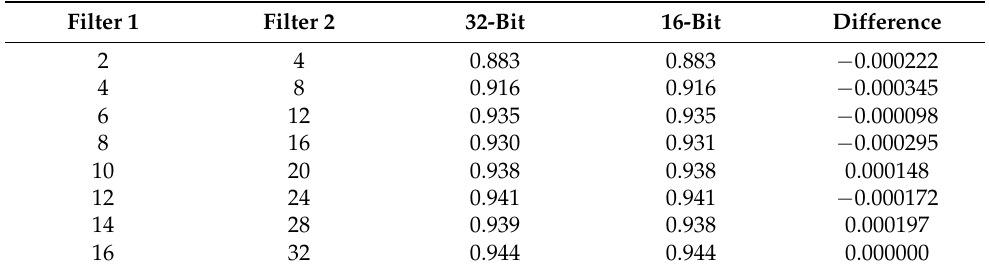
Table 2. Overall accuracy of prediction of the ResNet-18 model in 32-bit and 16-bit precision along with the difference between 32- and 16-bit shown in different filter configurations.